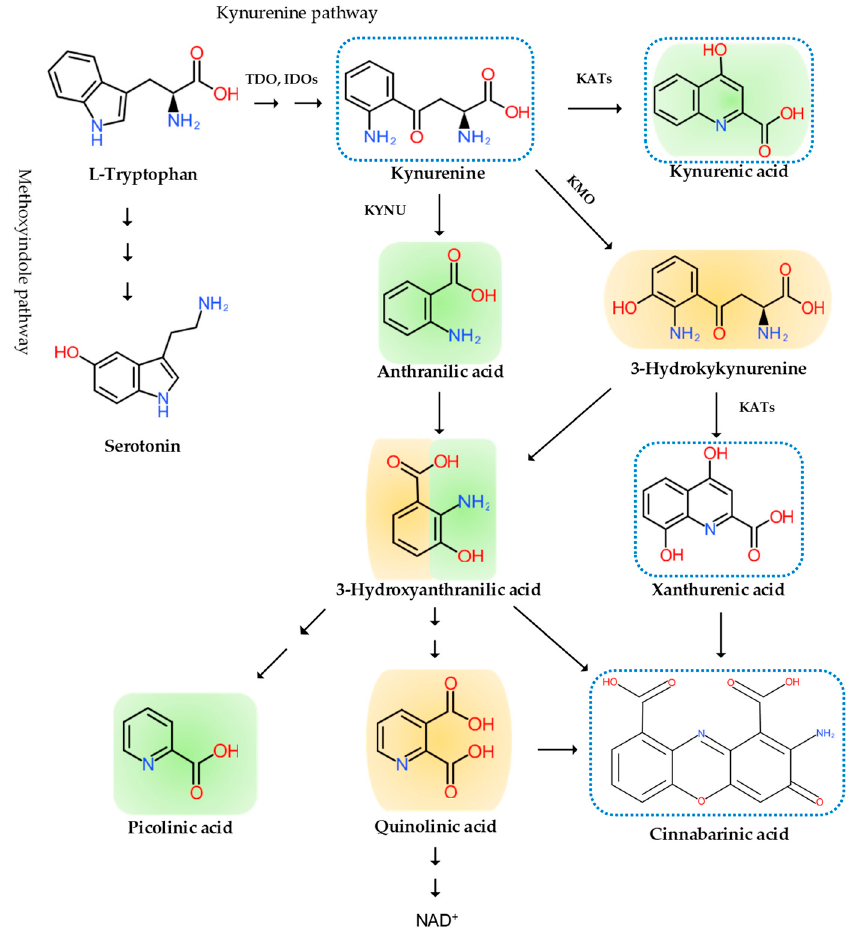
Figure 3. The tryptophan (TRP)–kynurenine (KYN) metabolic pathway and its metabolites. The pathway varies from the type of cells. Some enzyme is missing in some cells, not producing some metabolites. The TRP–KYN metabolic pathway synthesizes various metabolites, including oxidants ( orange color ), antioxidants ( green color ), and immunomodulators ( blue dotted line ). TDO: tryptophan 2,3-dioxygenase; IDO: indoleamine 2, 3-dioxygenase; KYNU: kynureninase; KMO: kynurenine-3-monooxygenase; KATs: kynurenine aminotransferases.